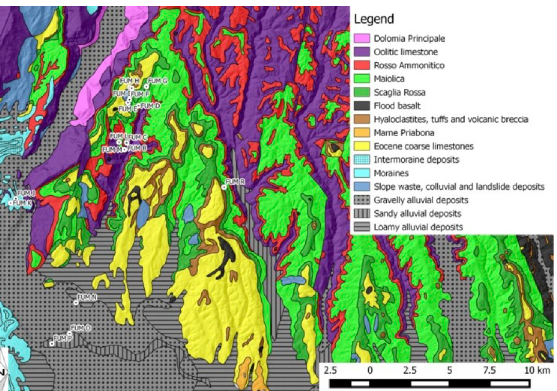
Fig 2. Geology of the monti lessini and nearby areas of veneto with the localities sampled for the strontium isotope baseline. Geo-topographic data have been downloaded from http://www.regione.veneto.it/web/ambiente-e- territorio/geoportale and http://www.territorio.provincia.tn.it/portal/server.pt/community/portale_geocartografico_ trentino. These have been elaborated using open source QGIS 2.4 Chugiak (Quantum GIS) software available at http:// www.qgis.org/it/site/ and adopting Monte Mario / Italy zone 1 as reference system. The figure is similar but not identical to the original image and is therefore for illustrative purposes only.